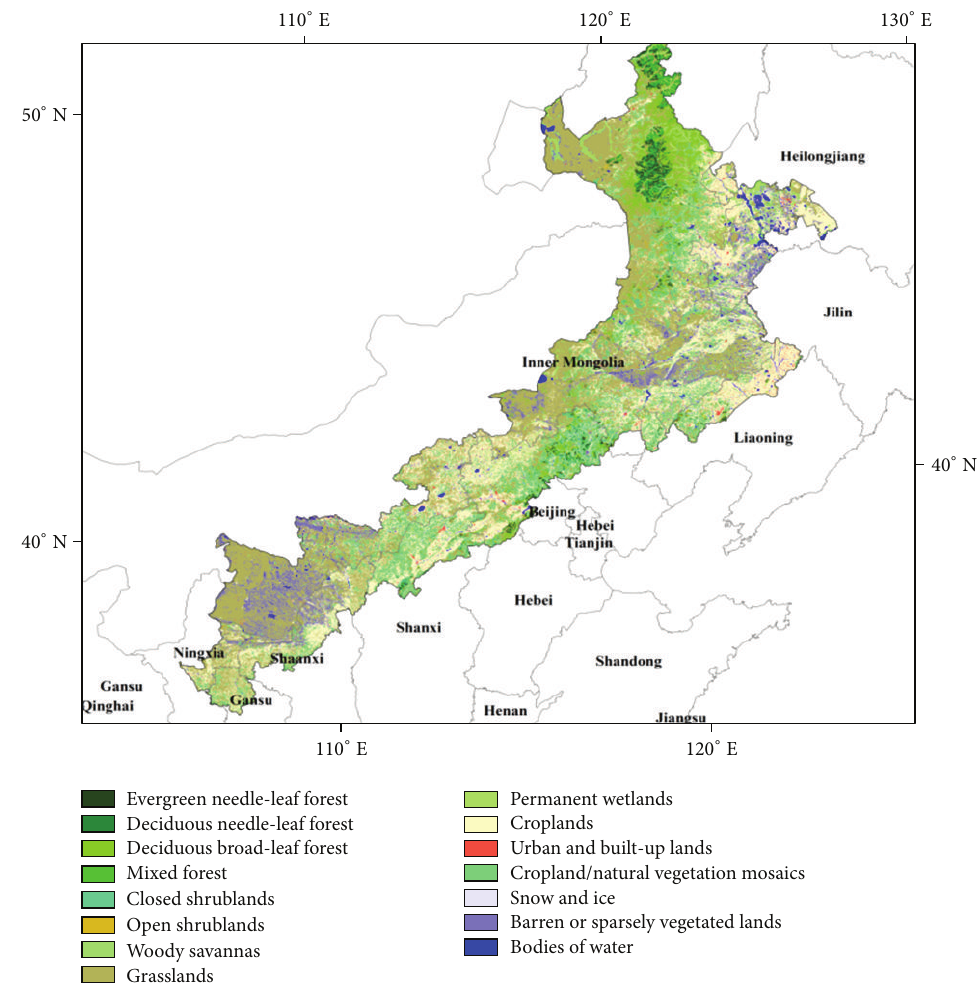
Figure 5: The transformed land cover map over farming-pastoral ecotone in